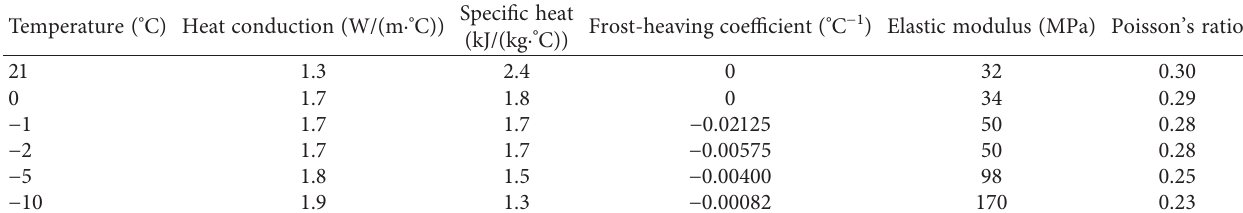
Table 2: Related parameters of the coarse sand layer at different